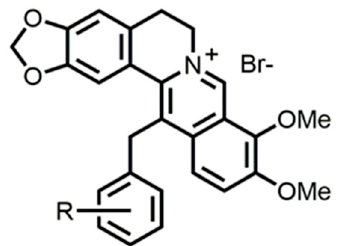
Figure 1. Structure of berberine derivatives.